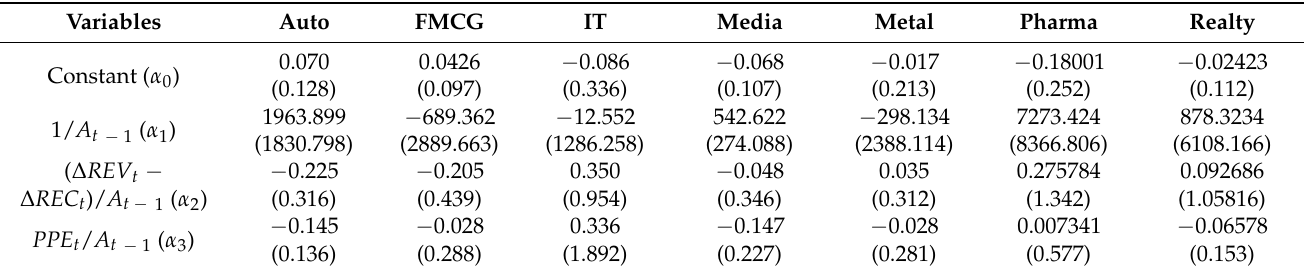
Table 4. Summary statistics (mean and standard deviation) of the individual industry wise regression estimators of the Modified Jones model.